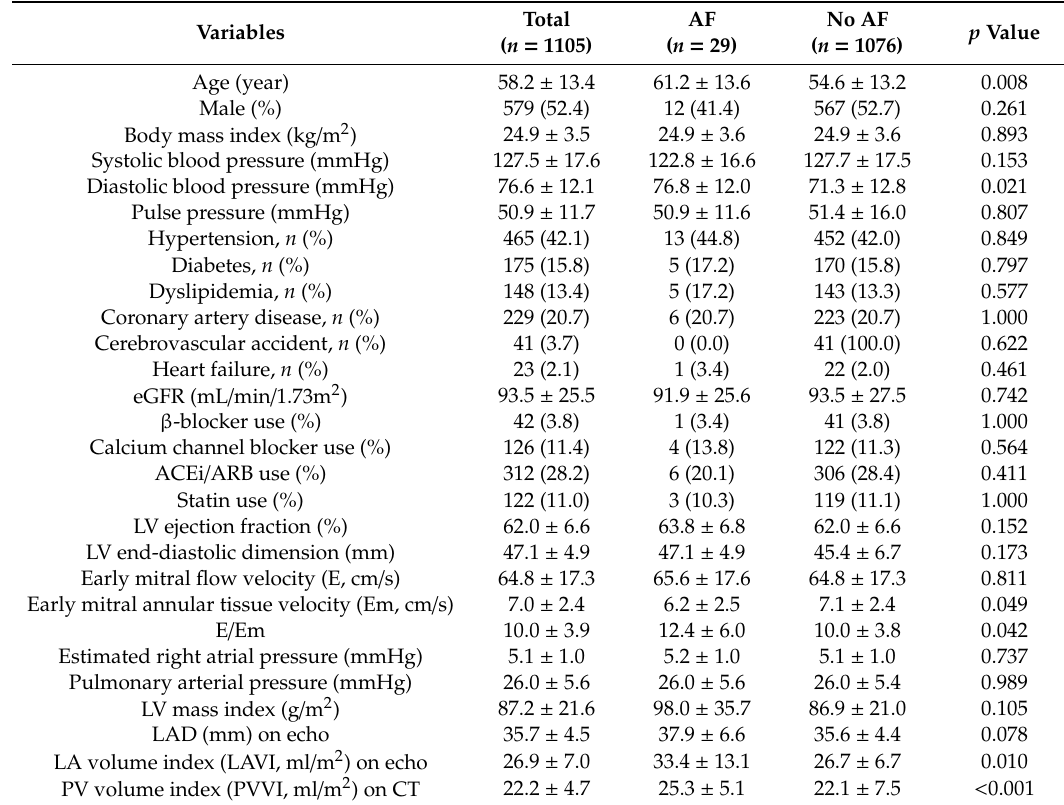
Figure 2. Flow chart for the inclusion and exclusion of the study. CCTA = cardiac computed tomography angiography, ECG = electrocardiography, TTE = transthoracic echocardiography. Table 1. Baseline clinical and echocardiographic characteristics according to the new-onset AF status at follow-up.